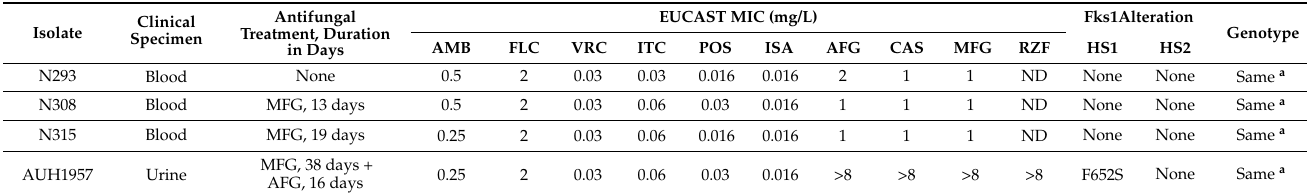
Table 1. Clinical and microbiological data of C. parapsilosis